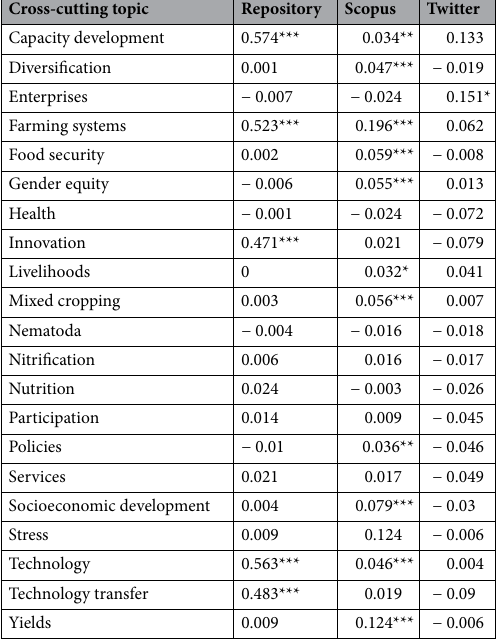
Table 3. Correlations between ‘Climate change’ and cross-cutting topics identified in the datasets. *p < 0.10, **p < 0.05, ***p < 0.01.